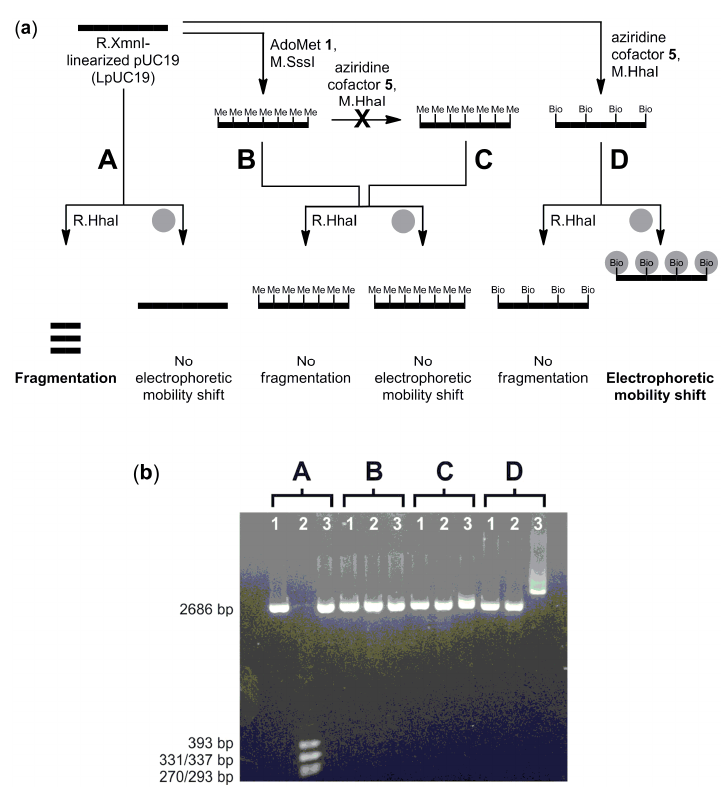
Figure 5. CpG-methylation detection using aziridine cofactor 5 and M.HhaI. ( a ) Reaction scheme to demonstrate specific detection of non-methylated CpG sequences within the M.HhaI recognition sequence by electromobility shift assay (EMSA) (grey sphere = streptavidin; Bio = biotin); ( b ) Agarose gel (1%) electrophoresis of unmodified (A), CpG-methylated (B), CpG-methylated and treated with 5 and M.Hhal (C) and biotin-labeled (D) linearized pUC19 plasmid DNA (LpUC19). Lanes 1: plasmid DNA from A, B, C or D; Lanes 2: plasmid DNA from A, B, C or D incubated with R.Hhal; Lanes 3: plasmid DNA from A, B, C or D incubated with streptavidin. The slight smearing of the DNA in Lane D3 can be explained by a small amount of streptavidin-crosslinked plasmid molecules as observed by electron microscopy. The DNA length is given in base pairs